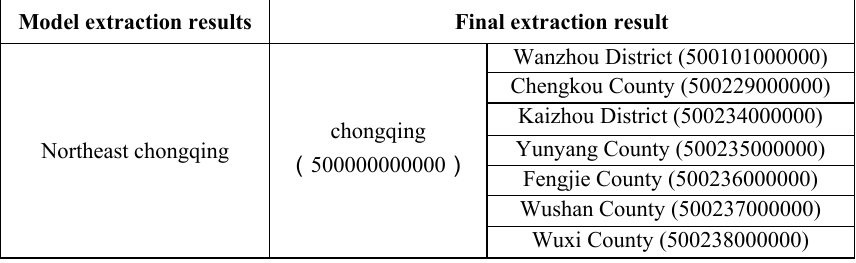
Table 1. Example of standardization of extraction results for early warning affected areas. Model extraction results